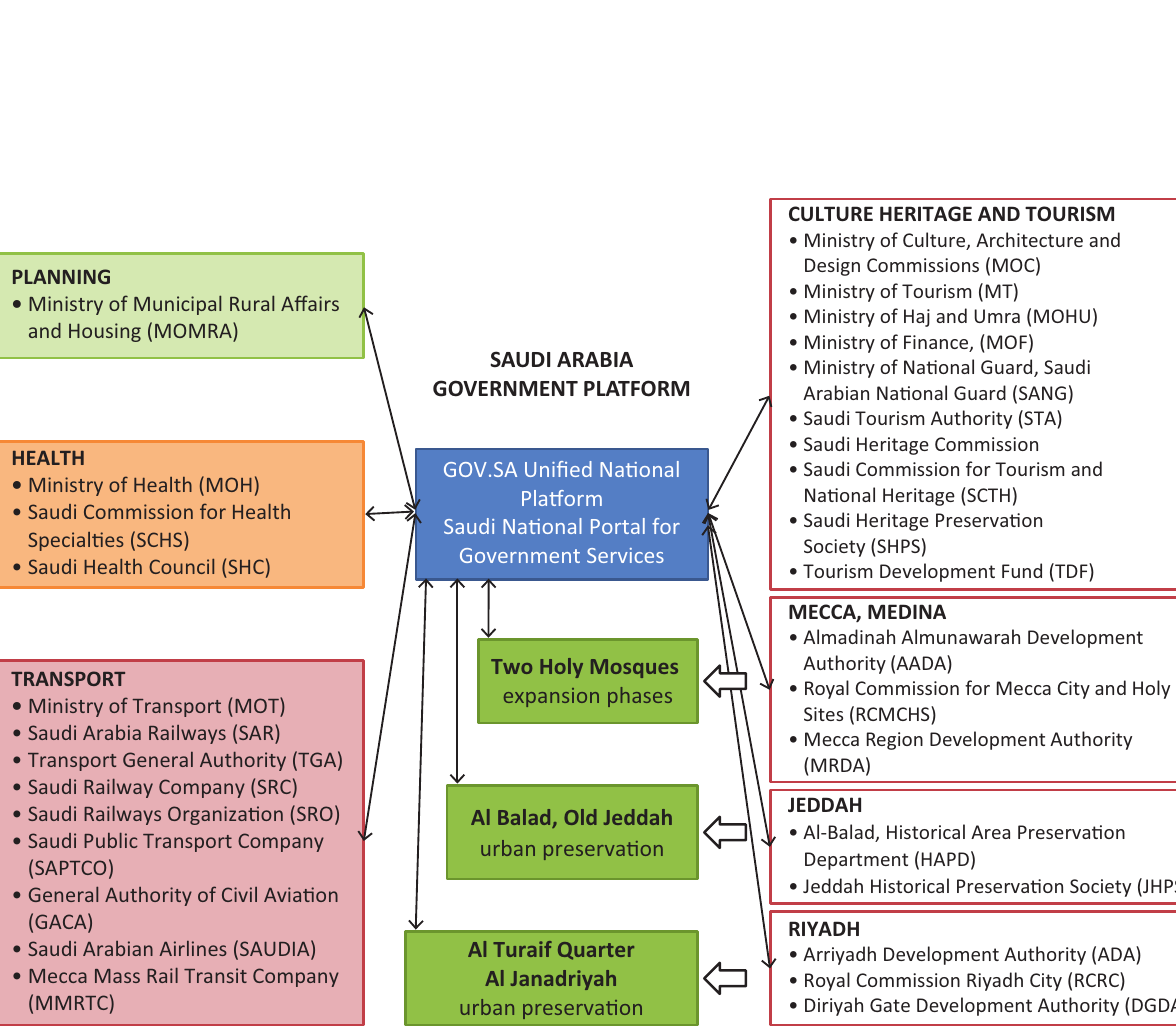
Figure 7. The unified national platform Saudi National Portal for Government Services: Proposed framework for collabora‐ tion between ministries and governmental